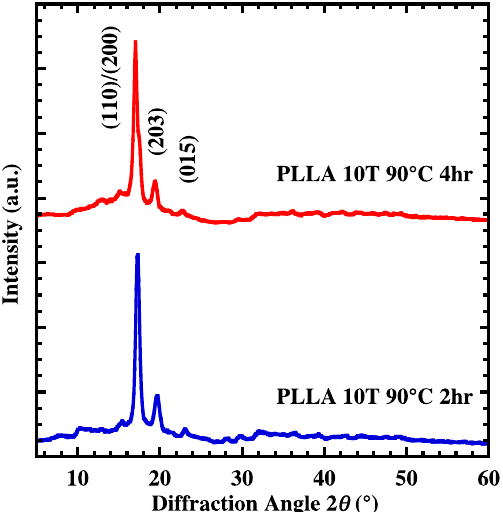
Figure 3. XRD patterns of PLLA10T2 and PLLA10T4 films. Table 1. X c and crystal size of PLLA 10T films at each heat treatment time.